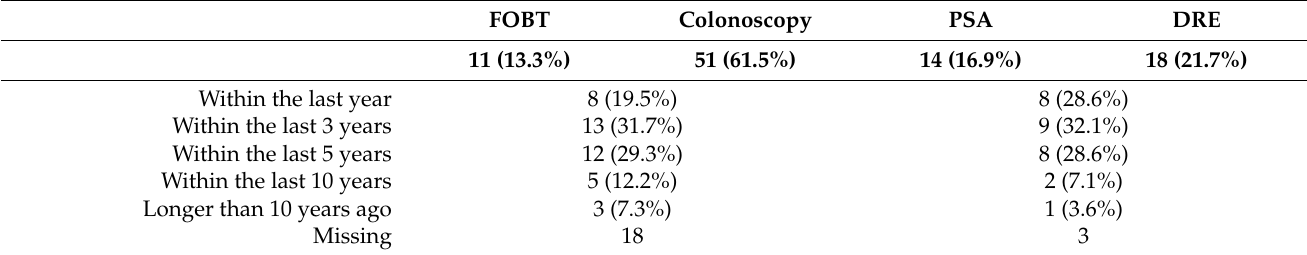
Table 2. Type of cancer screening tests and years since the last screening test.